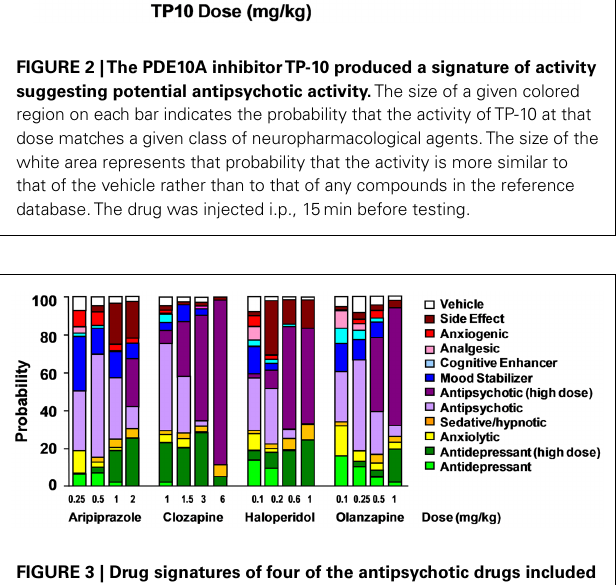
FIGURE 3 | Drug signatures of four of the antipsychotic drugs included in the reference dataset: aripiprazole, clozapine, haloperidol, and olanzapine. Numbers below each bar represent doses in mg/kg administered i.p. 15min before testing.